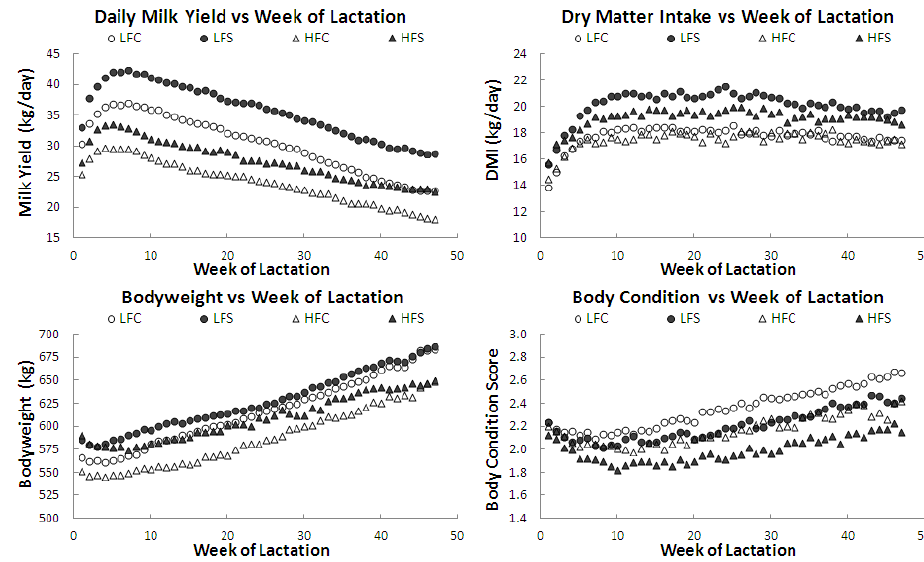
Figure 1. Daily milk yield, dry-matter intake, bodyweight and body condition score throughout lactation. LFC stands for Low Forage Control, LFS for Low Forage Select, HFC for High Forage Control and HFS for High Forage